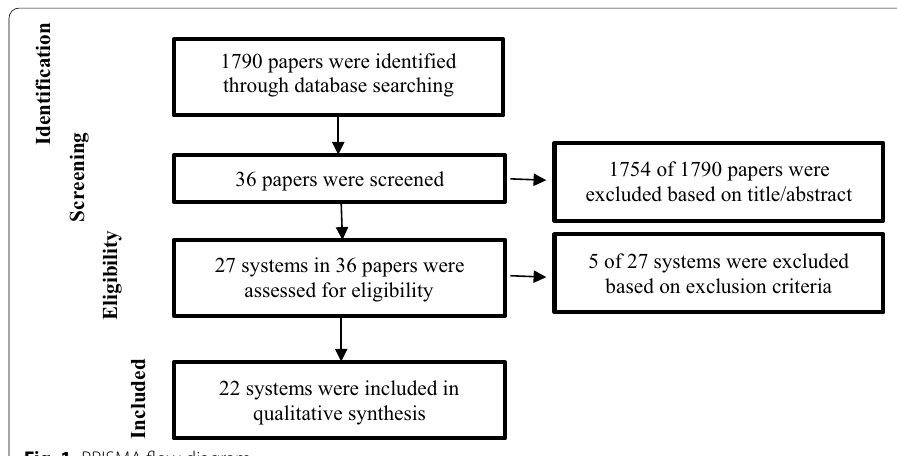
Fig. 1 PRISMA flow